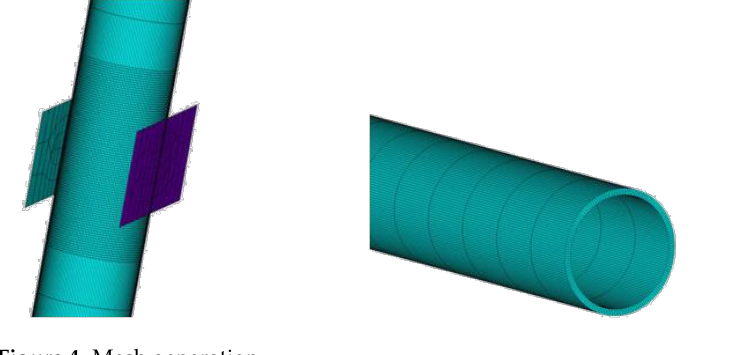
Figure 4. Mesh generation. Figure 4. Mesh Table 1. Parameters of modeling.